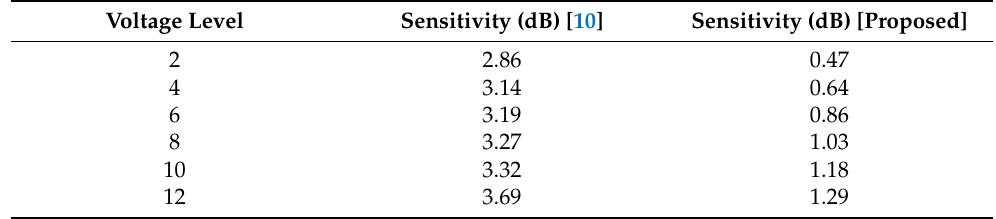
Table 4. Level of detection (sensitivity).